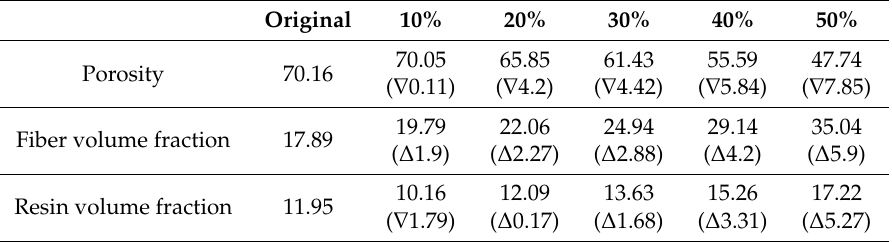
Table 3. Components of fiber volume fraction for the generation of the model microstructures.